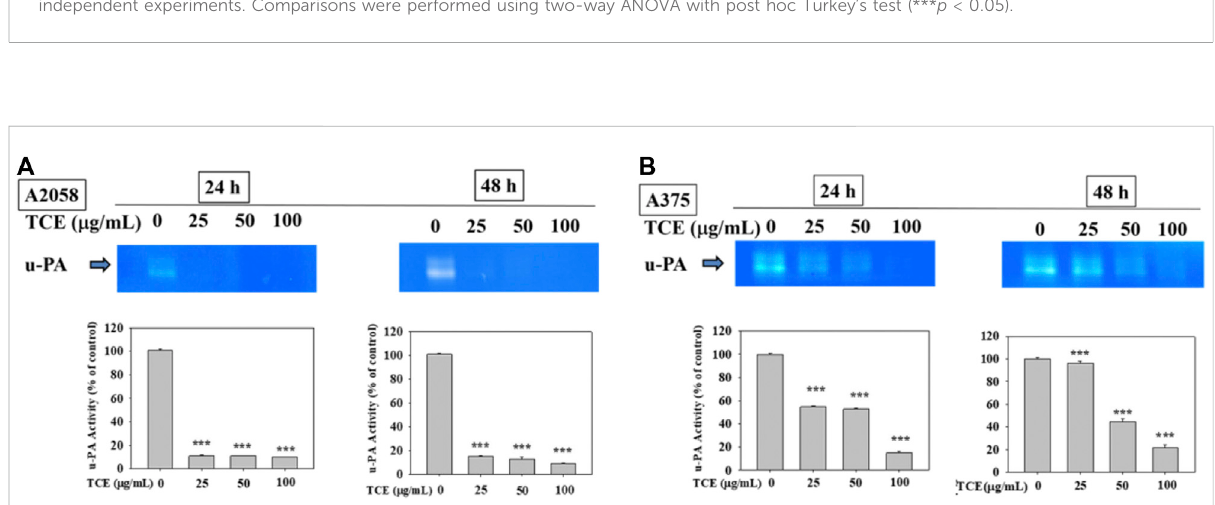
FIGURE 2 Effects of TCE on the activity of MMP-2. A2058 cells and A375 were treated with (0, 25, 50, 100 μ g/ml) of TCE for 24 h and 48 h, respectively, then subjected to gelatin and casein zymography to analyze the activities of MMP-2 (A , B) . The values represented the means ± SD of at least three independent experiments. Comparisons were performed using two-way ANOVA with post hoc Turkey ’ s test (*** p < 0.05).